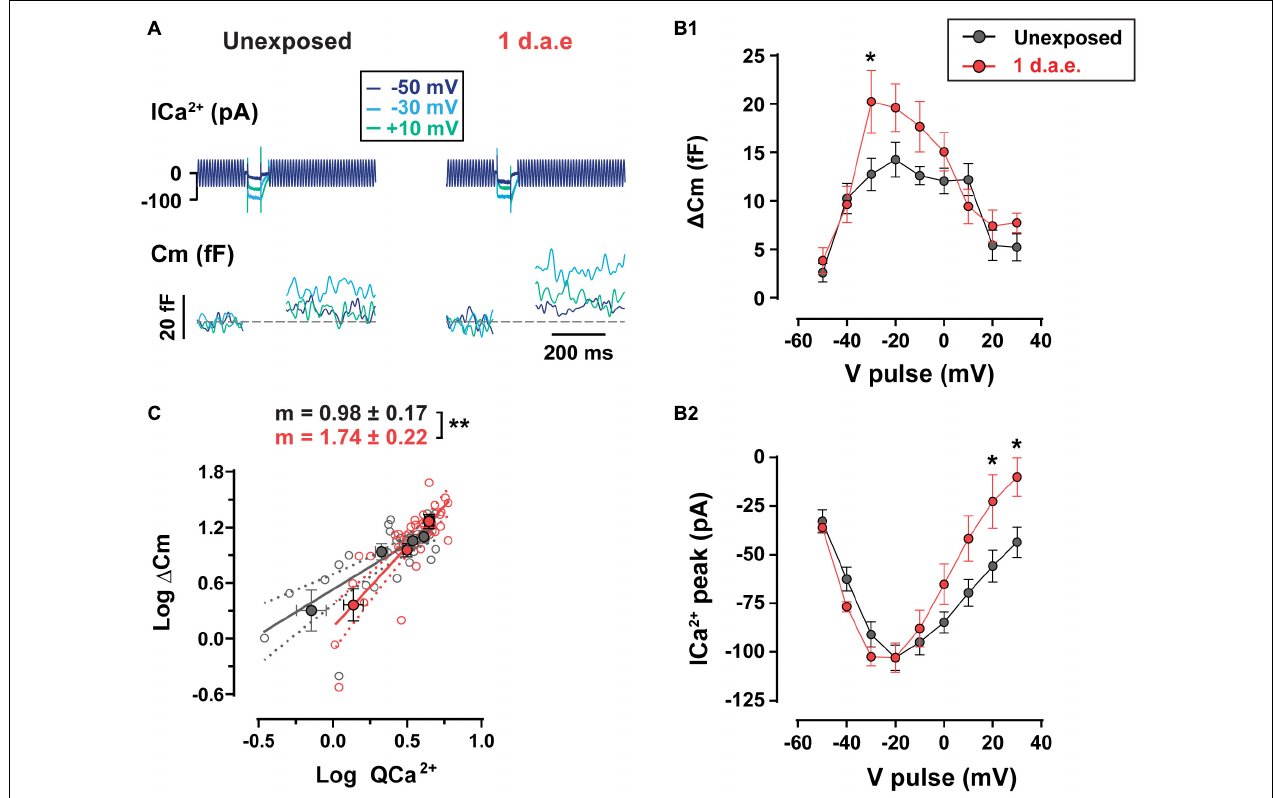
FIGURE 4 | Increased exocytosis and altered Ca 2 + -dependence of release were found in noise-exposed inner hair cells (IHCs). (A) Calcium currents (ICa 2 + ) and membrane capacitance (Cm) traces of representative control (Unexposed) and 1 d.a.e. IHCs elicited by 50 ms depolarizations at different voltages. (B1) Measurement of exocytosis ( (cid:49) Cm) and (B2) corresponding Ca 2 + currents (ICa 2 + ) for control (Unexposed, black traces) and 1 d.a.e.(red traces) IHCs obtained during the application of 50 ms pulses at different voltages. Statistical comparisons were made using Two-way ANOVA followed by Holm-Sidak multiple comparisons test. * p < 0.05. (C) Analysis of Ca 2 + dependence of vesicle release in control and exposed IHCs. Gray and red filled circles correspond to the mean exocytic responses triggered by pulses in the range of − 50 to − 20 mV plotted vs. the mean corresponding Ca 2 + current integrals for each potential in a double-logarithmic scale for unexposed and 1 d.a.e mice, respectively. Linear regressions were fitted using all the observations (empty gray and red circles) of each group and slopes of the linear fit ( m ) were obtained. Slope comparisons were made using ANCOVA test. ** p < 0.01. Data is shown as mean ± standard error of the mean